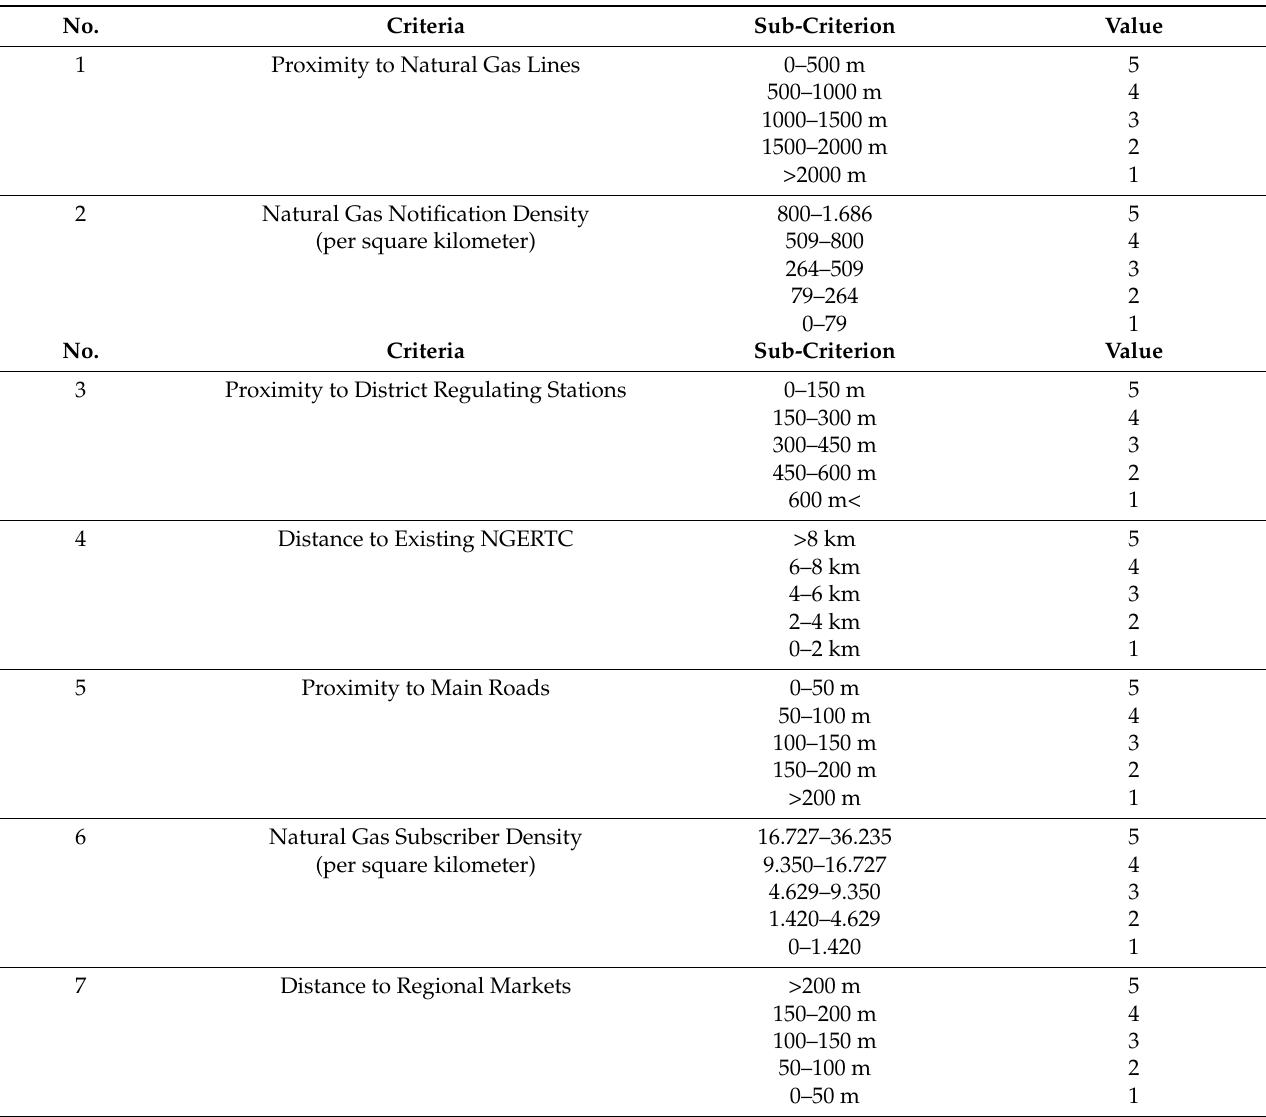
Table 4. Criterion values for new